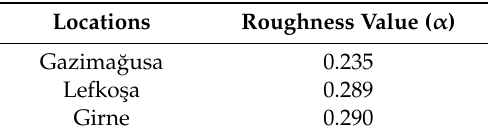
Table 5. Roughness values for different sites.